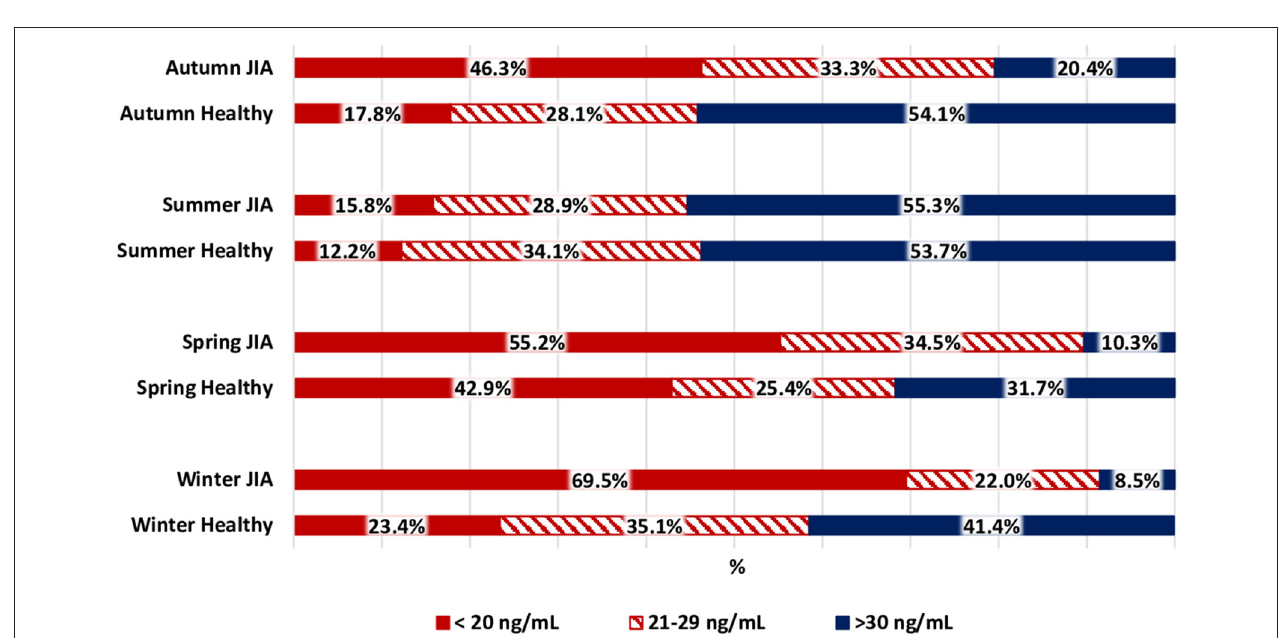
than among those who did not receive supplementation (Me, 21.3 [12.6; 29.8] ng/mL; P = 0.013). Similarly, in the control group, vitamin D supplementation was associated with higher serum calcidiol levels (with supplementation, Me, 34.5 [25.0; 44.6] ng/mL, and without supplementation, Me, 24.4 [18.7; 31.6] ng/mL; P < 0.0001). Among those who did not receive vitamin D supplementation, controlling for a background